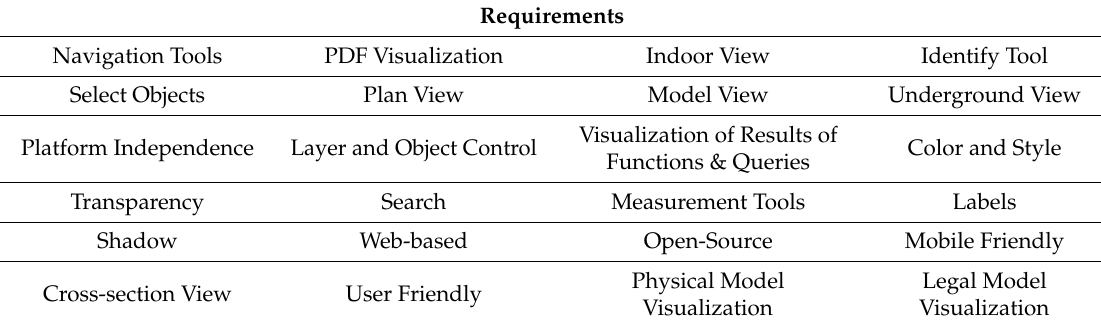
Table 1. List of the considered requirements for the prototype development according to Shojaei